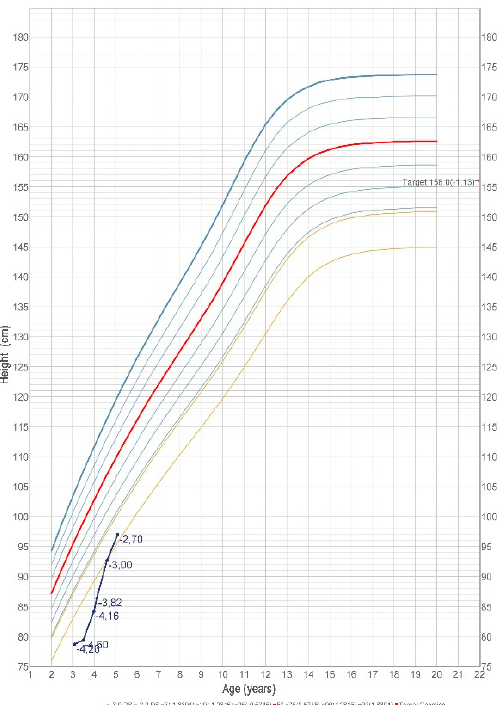
Figure 3. Increase in growth after 18 months of GH and LT4 therapy.